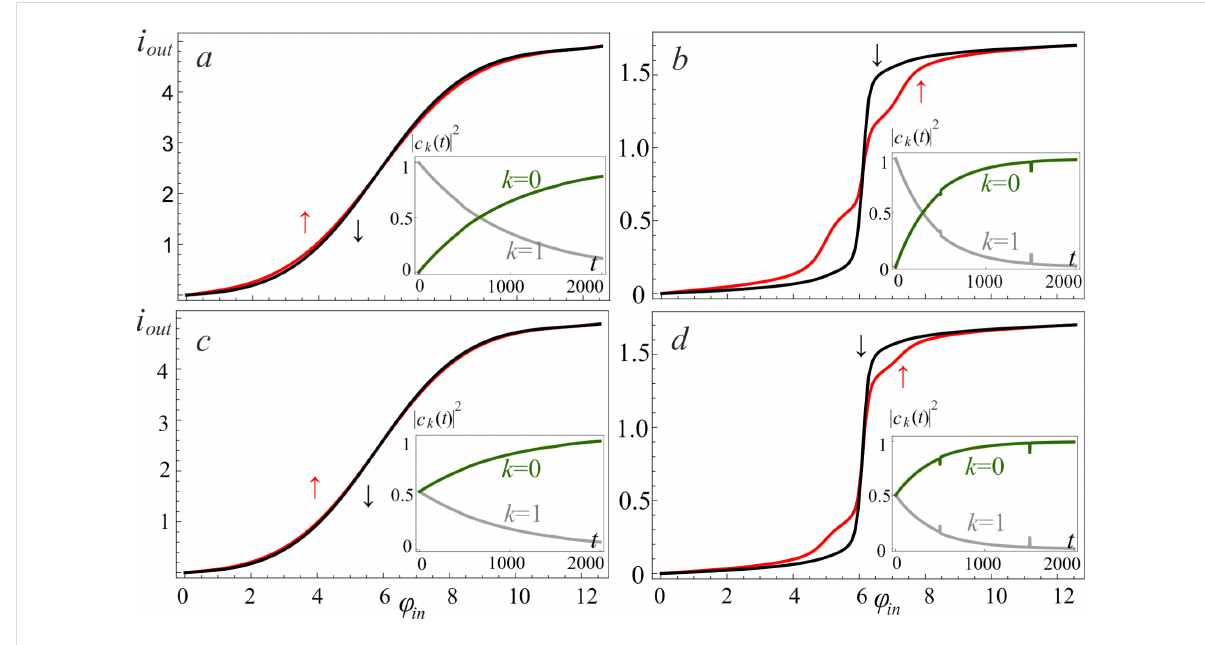
Figure 10: The neuron activation function for l = 0.1 (a, c) and l = 2.5 (b, d) when the cell is initialized in the first excited level (a, b) and in the super- position of two basic states (c, d). The input flux parameters are as follows: D = 0.008, A = 4 π , t 1 = 500; the renormalized coupling constant λ = 0.005. The insets present the corresponding populations | c k ( t )| 2 of the ground state, k = 0, and the first excited, k = 1, energy